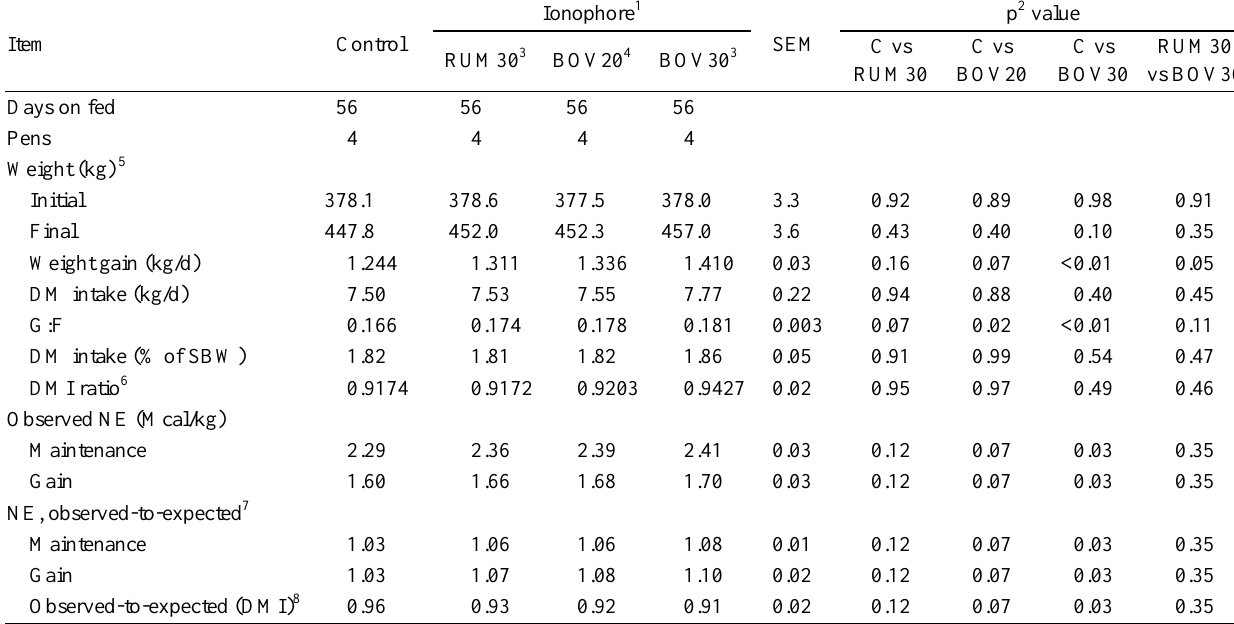
Table 3. Treatments effects on growth performance responses in feedlot